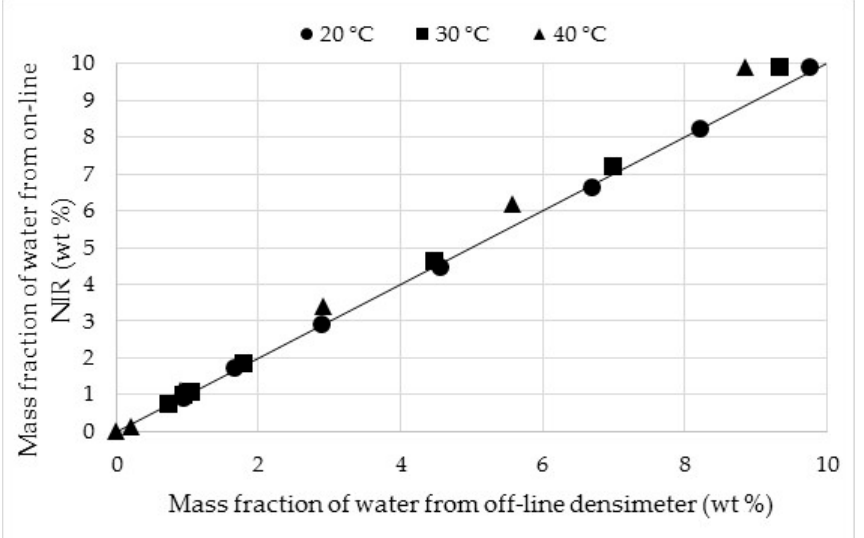
Figure 6. Comparison of measurements of water content from on-line NIR and off-line densimeter depending the temperature.